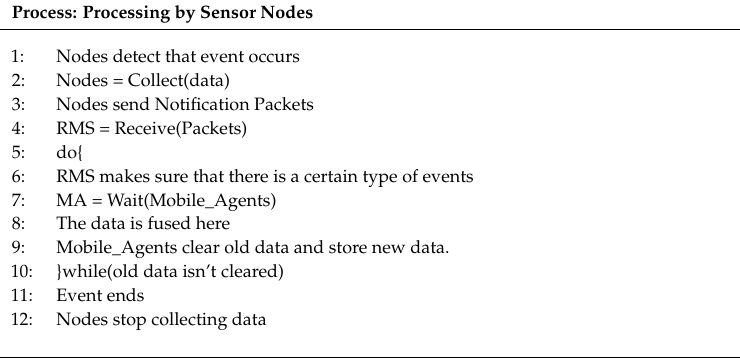
Table 6. Process of sensor node.